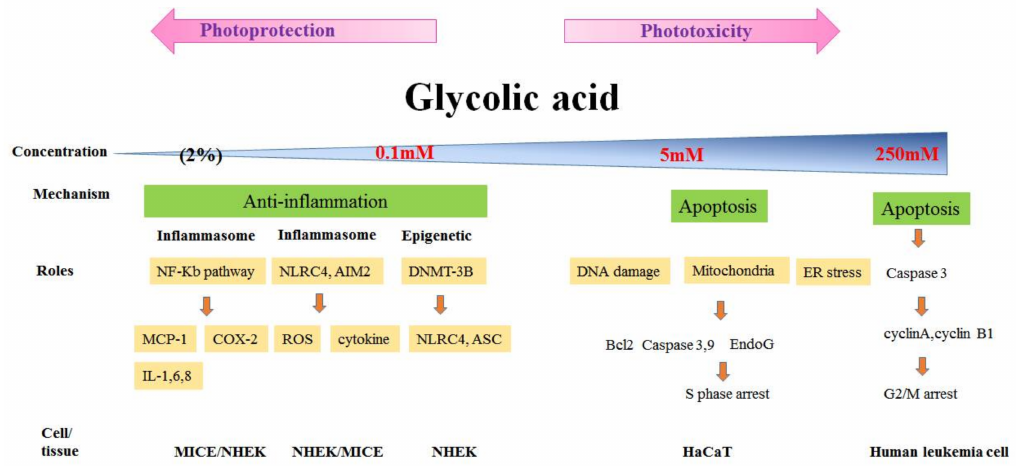
Figure 4. Review of the various biological effects (phototoxicity or photoprotection) and mechanisms (apoptosis or anti-inflammation) of GA on human keratinocytes (HaCaT or NHEK), and in the mice animal